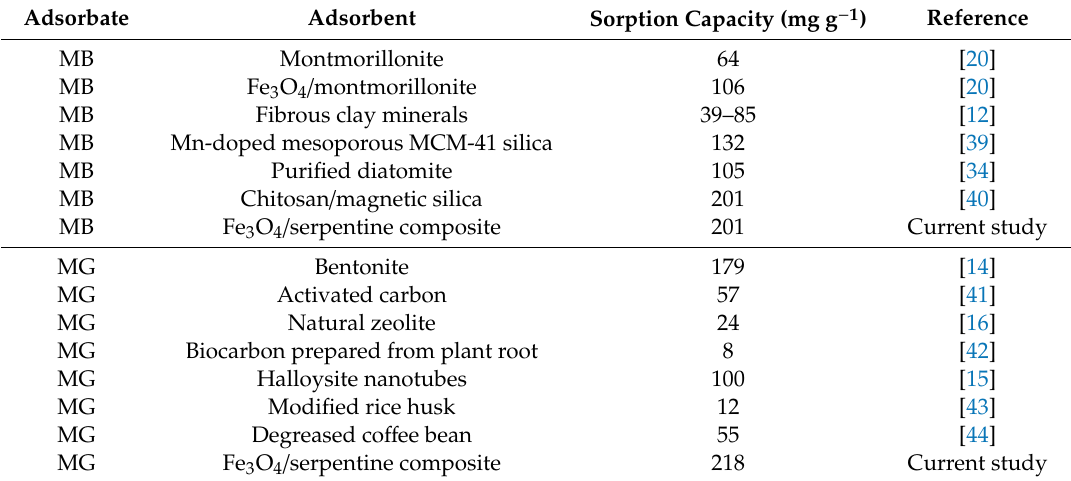
Table 1. Comparison of adsorption capacities (based on Langmuir model) for di ff erent materials reported in the literature and the obtained MNP / SP